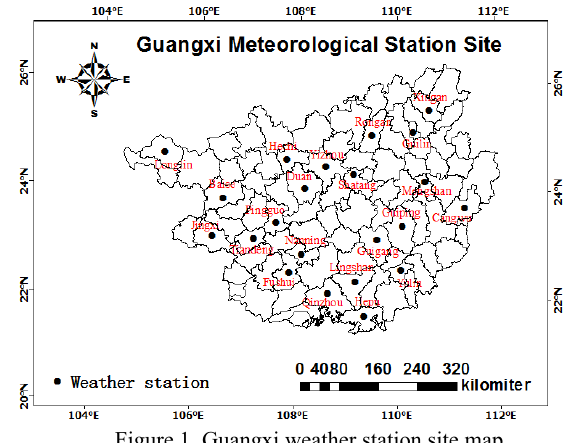
Figure 1. Guangxi weather station site